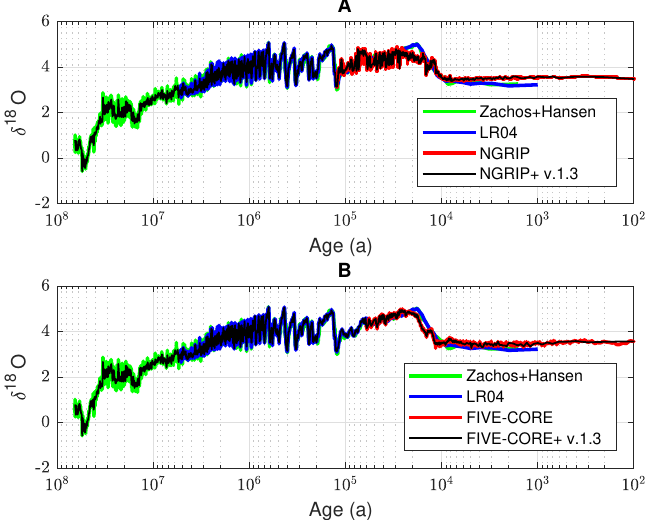
Figure 1. δ 18 O glacial proxies. Combination of scaled δ 18 O curves from Lisiecki and Raymo [12], Zachos [13], NGRIP [14], and Buizert et al. [15], depicted with colours. Black lines show the simplified curves used by NUNAIT for latitudes north ( A ) and south ( B ) of latitude 55 ◦